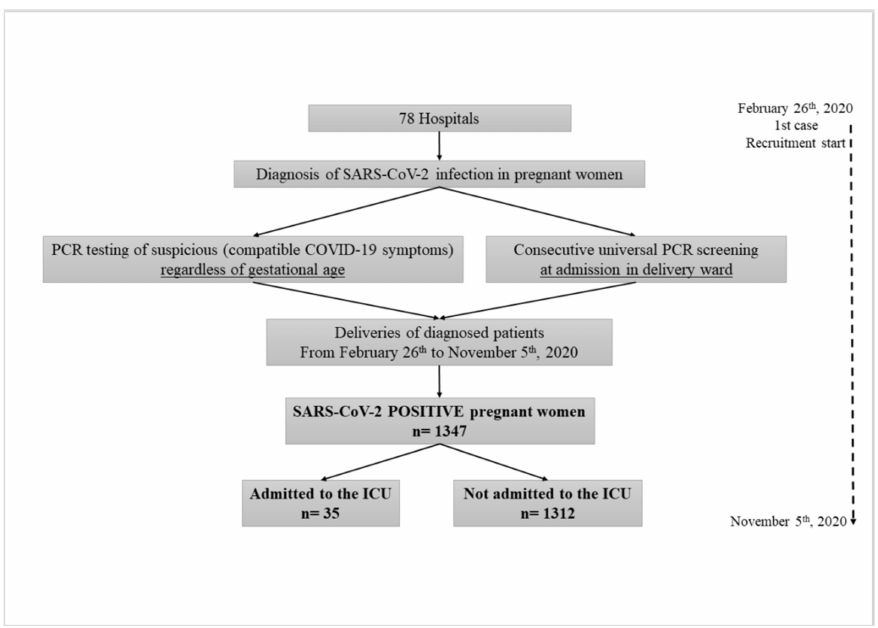
Figure 1. Flow chart of the study